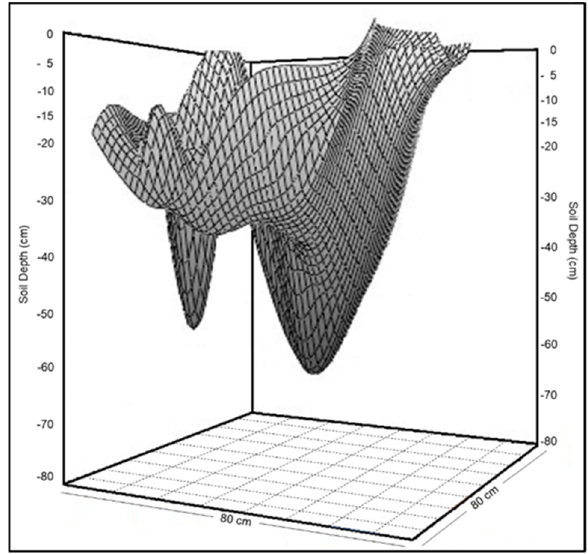
Figure 5. Example 3D schematic representation of the bulb formed after the application of the KBr solution in year 1.